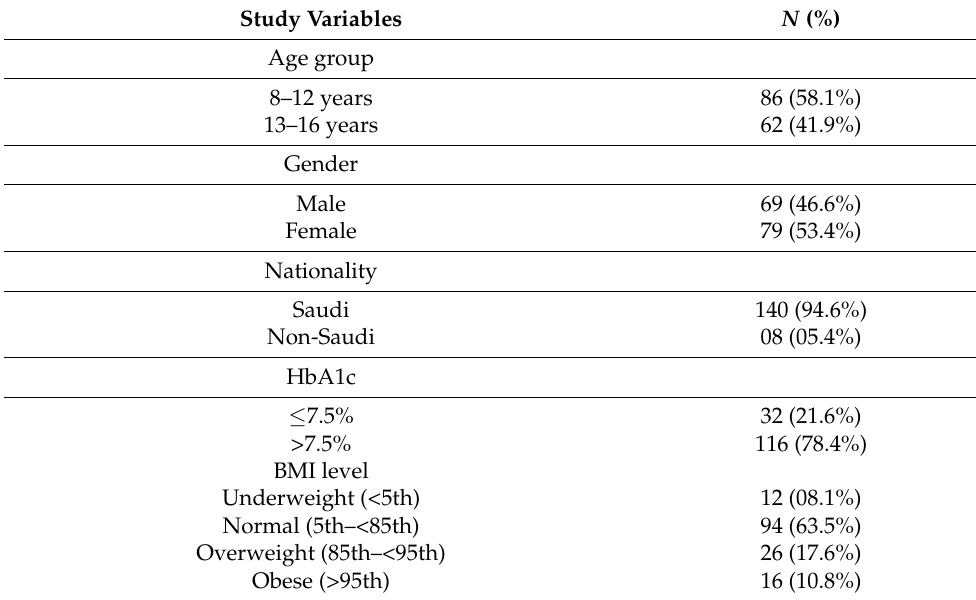
Table 1. Sociodemographic profiles of children with type 1 diabetes ( n =